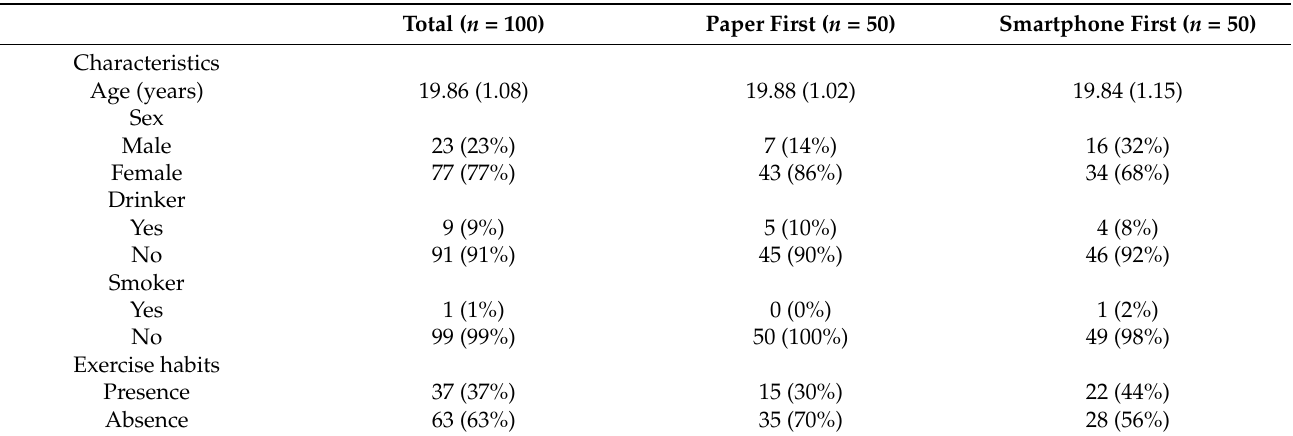
Table 1. Baseline characteristics of the two